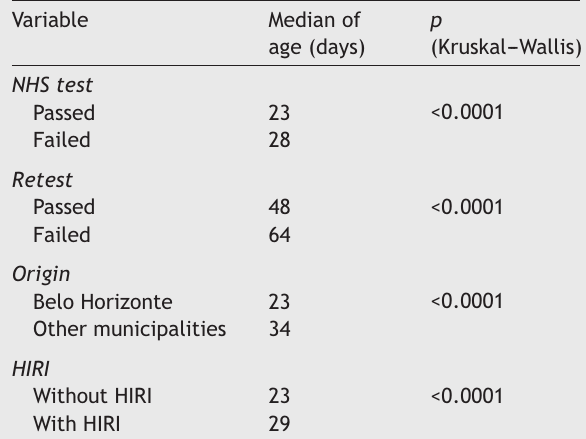
Table 3 Association among child’s age and the result of newborn hearing screening test and retest, origin of the child, and risk indicators for hearing loss, Belo Horizonte ---